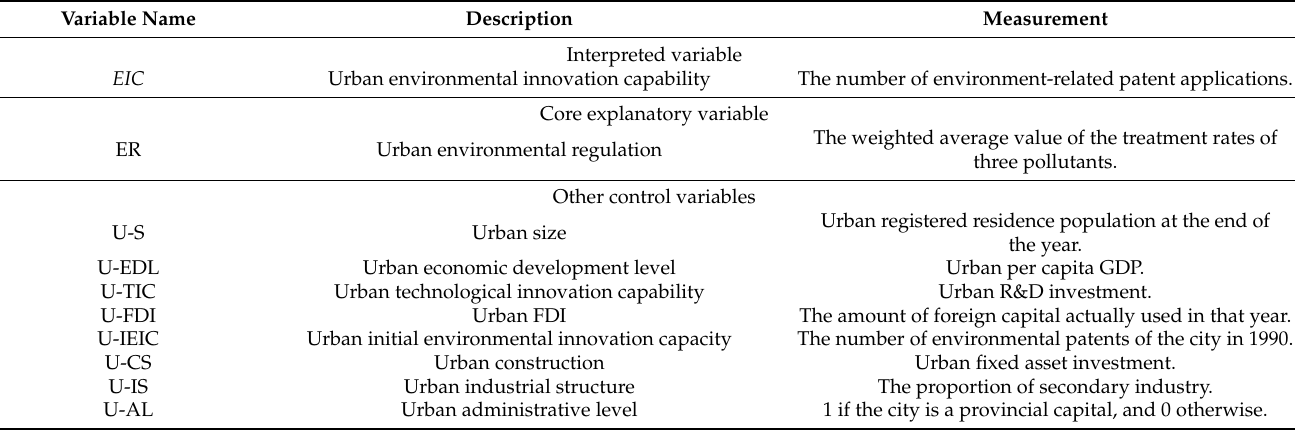
Table 3. Description of